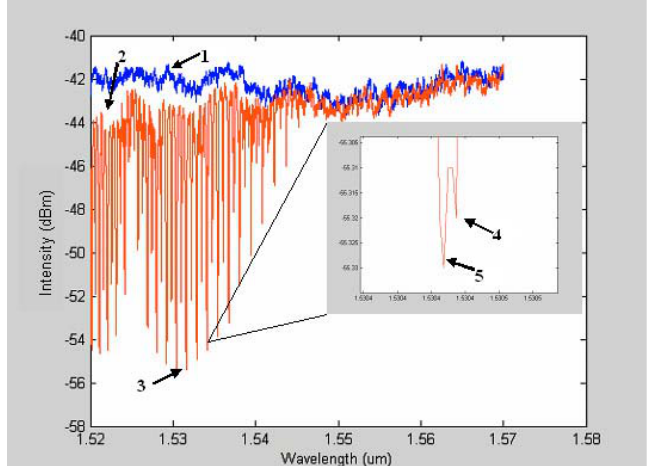
Figure 1. Absorption spectrum of Acetylene as measured by the newly developed SNSC optical fiber based sensor with features common in IR spectra: (1) Baseline (2) Area between baseline and transmitted light line representing background absorption or reflection losses (3) Absorption maximum of the vibration-rotation lines representing the maximum uptake of radiation energy by the H isotope maxima (5) 12 C H isotope acetylene molecules (4) 13 C 2 2 2 2